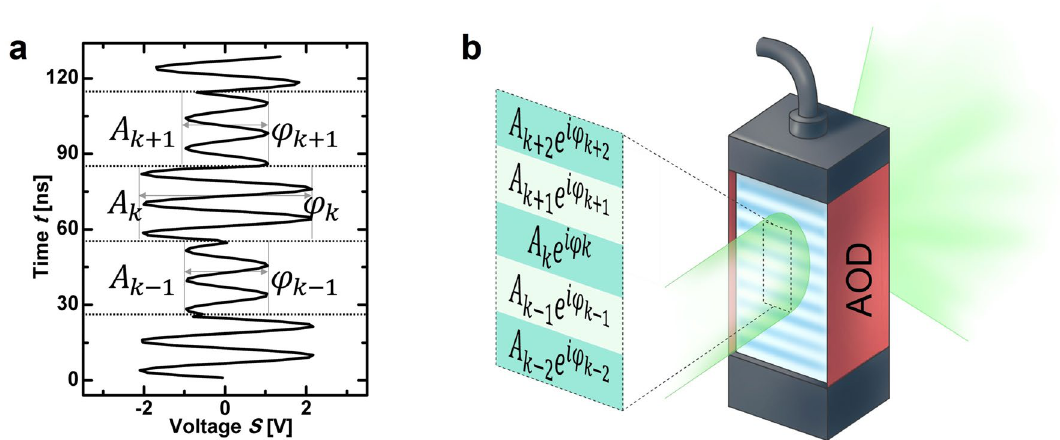
Figure 8. Electronic and optical representation of the digital hologram. ( a ) Electrical driving signal with encoded Fourier hologram G k . These complex modulated driving signals are generated with an arbitrary wavefront generator. ( b ) The reconstructed physical hologram G (x,t) displayed by the AOD has a similar amplitude and phase